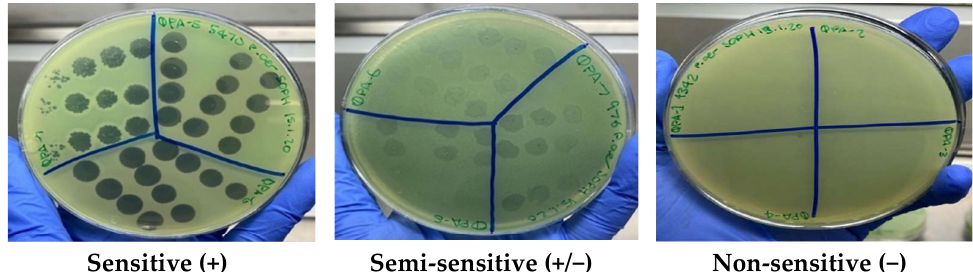
Figure 1. Bacteriophage Host Range Spot Assay. Double agar spot assay demonstrating the three clarities of plaques for phage sensitivity: sensitive (+), semi-sensitive (+/−) or non-sensitive (−) on the lawn of P. aeruginosa clinical isolates C420, C413 and C422 respectively. Table 1. Summary of Bacteriophage Host Range. * Based on the degree of lysis on the bacterial lawn, the spots were differentiated into three categories: sensitive (+), semi-sensitive (+/−) or non-sensitive (−). C450 to C457 represent P. aeruginosa strains isolated from cystic fibrosis patients whilst C420 to C432 represent P. aeruginosa strains isolated from non-cystic fibrosis patients.